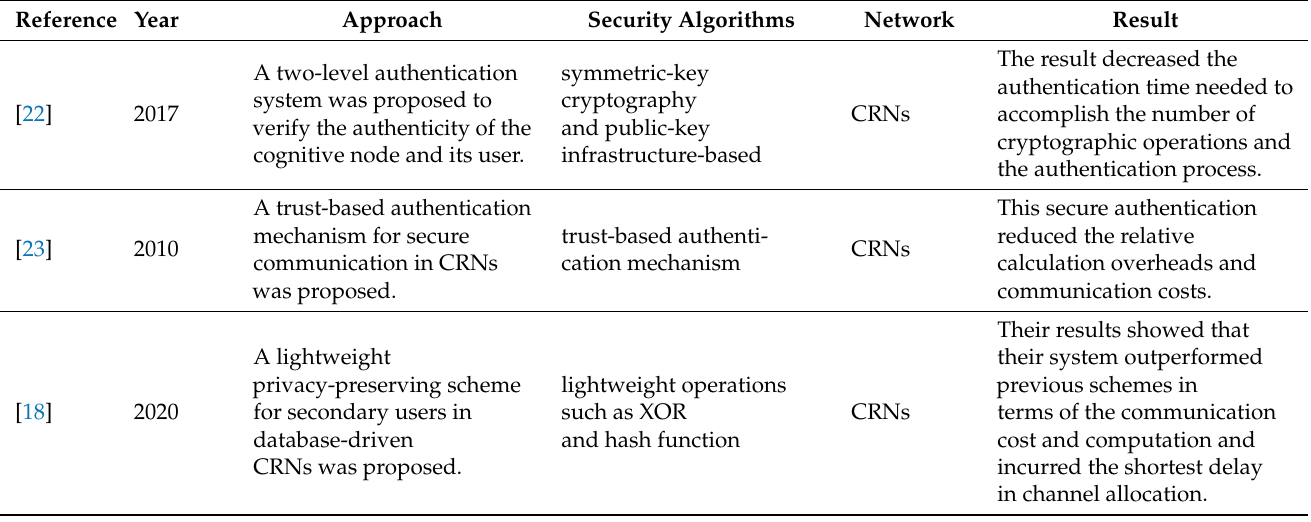
Table 1. Comparison of the most recent relevant